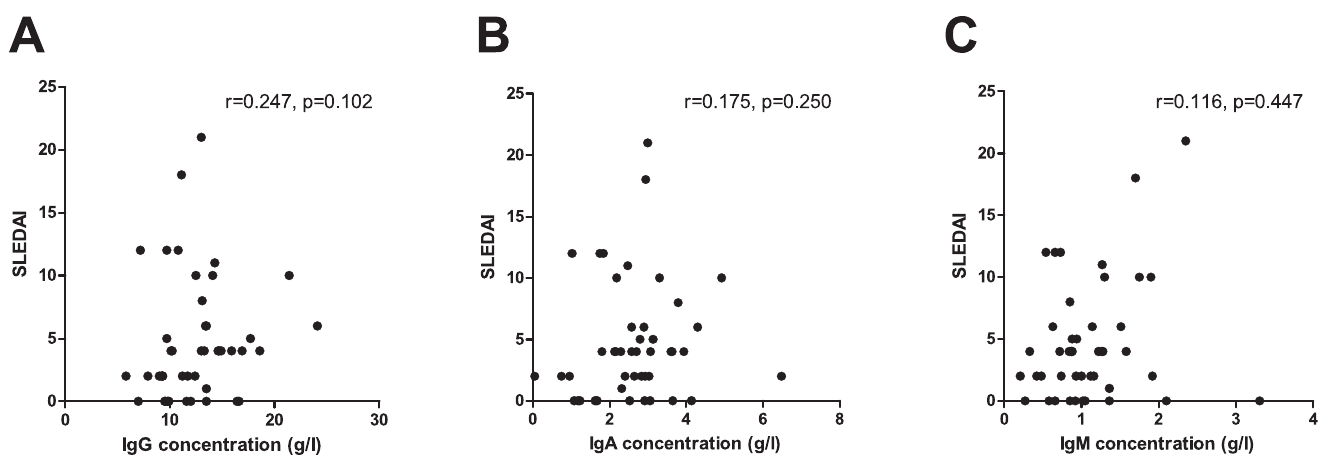
Fig 6. No correlation between SLEDAI scores and total immunoglobulin concentrations in SLE patients. No correlation between SLEDAI scores and total IgG, IgA and IgM in SLE patients (n = 45) with r-values of 0.247 (p = 0.102), 0.175 (p = 0.250) and 0.116 (p = 0.316) regarding total IgG, IgA and IgM, respectively. SLEDAI — systemic lupus erythematosus disease activity